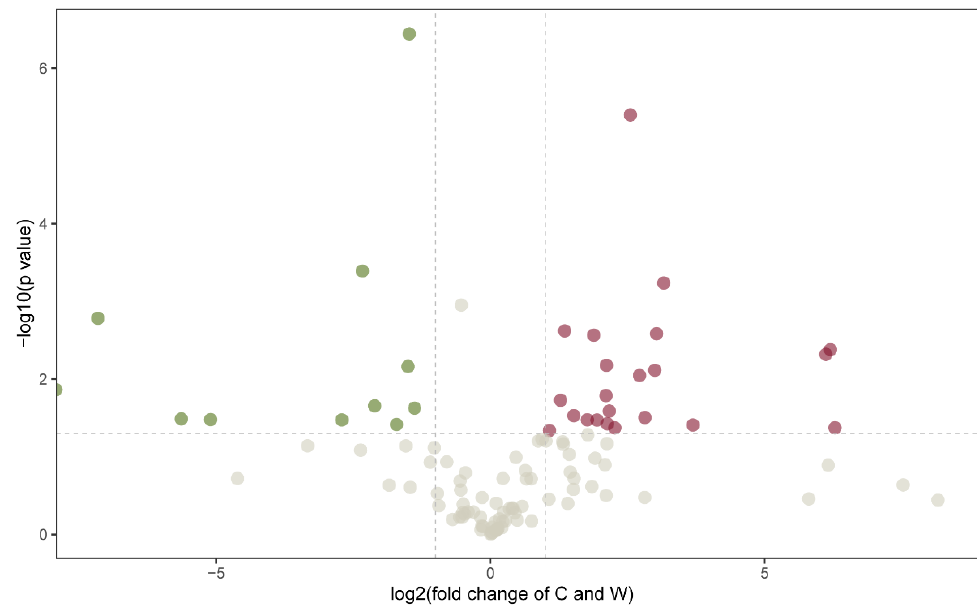
Figure 4. Volcano plots of the identified phytochemicals of the cultivated and wild-grown P. sibiricum . Detained information for these 33 differentiating phytochemicals is listed in Table